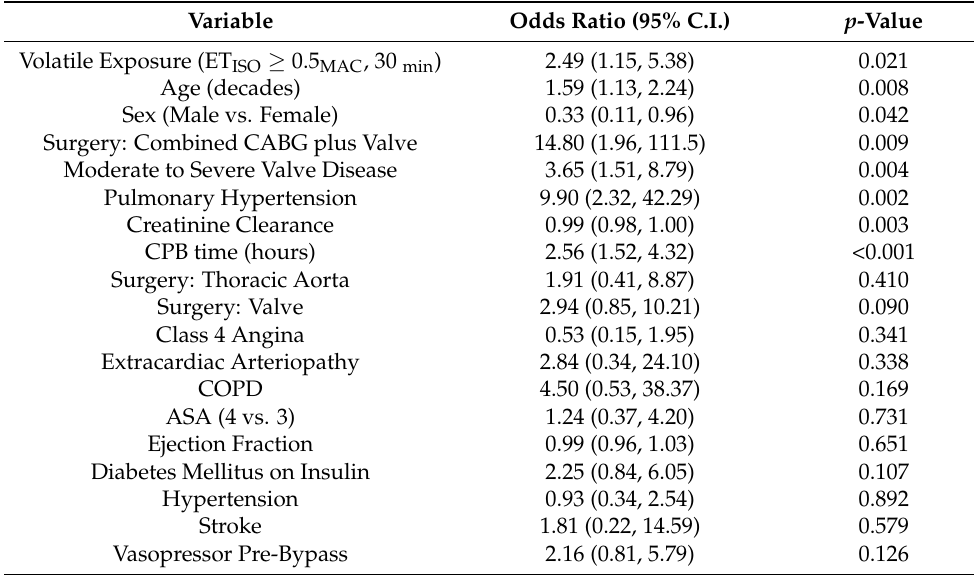
Table 4. Univariate Logistic Regression Models for Inotrope Use—Adjusted for Volatile Exposure (ET ISO ≥ 0.5 MAC , 30 min ) and Calculated Propensity Score.